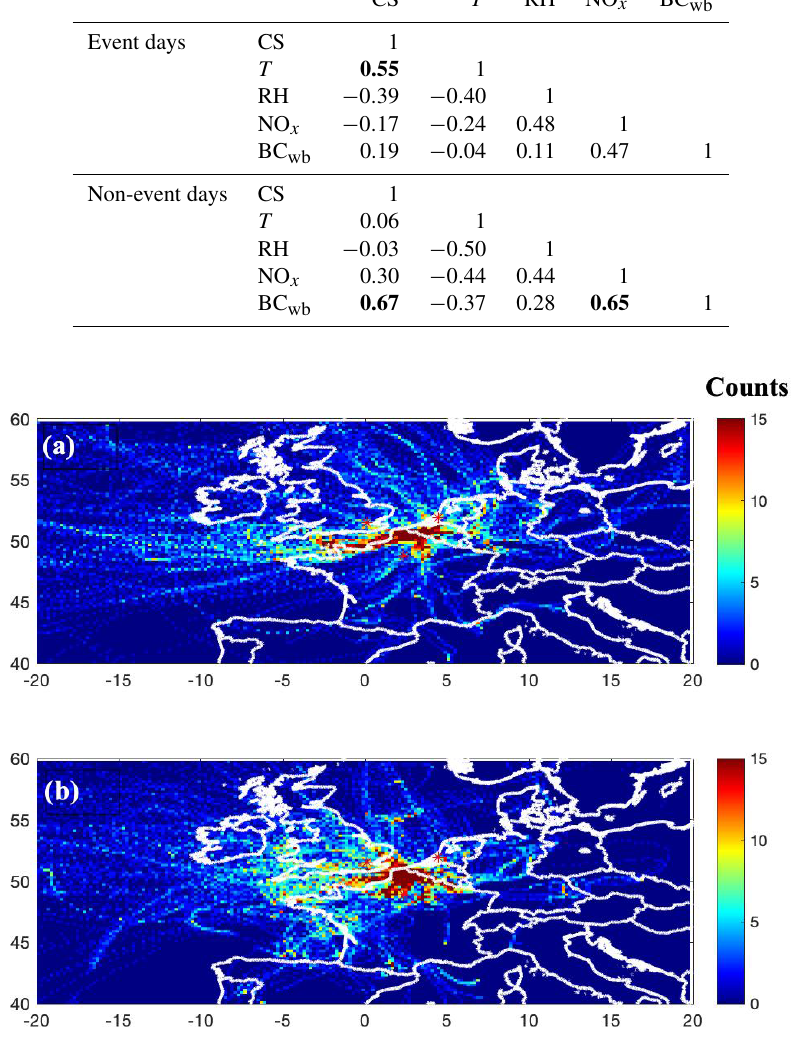
Figure 10. Three-day hourly back trajectories arriving at ATOLL between 09:00 and 14:00UTC during (a) NPF event and (b) non-event days. Back-trajectories were calculated for each hour at ATOLL arriving at half the boundary layer height using GDAS 1 ◦ × 1 ◦ meteorological data. The color contour represents the back trajectory crossing counts in each grid cell (resolution 0 . 2 ◦ × 0 . 2 ◦